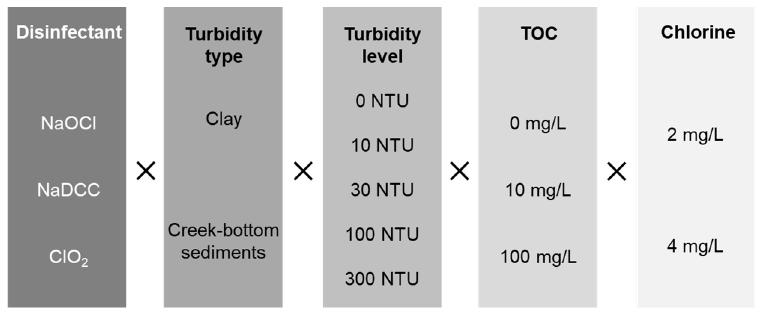
Figure 1. Testing